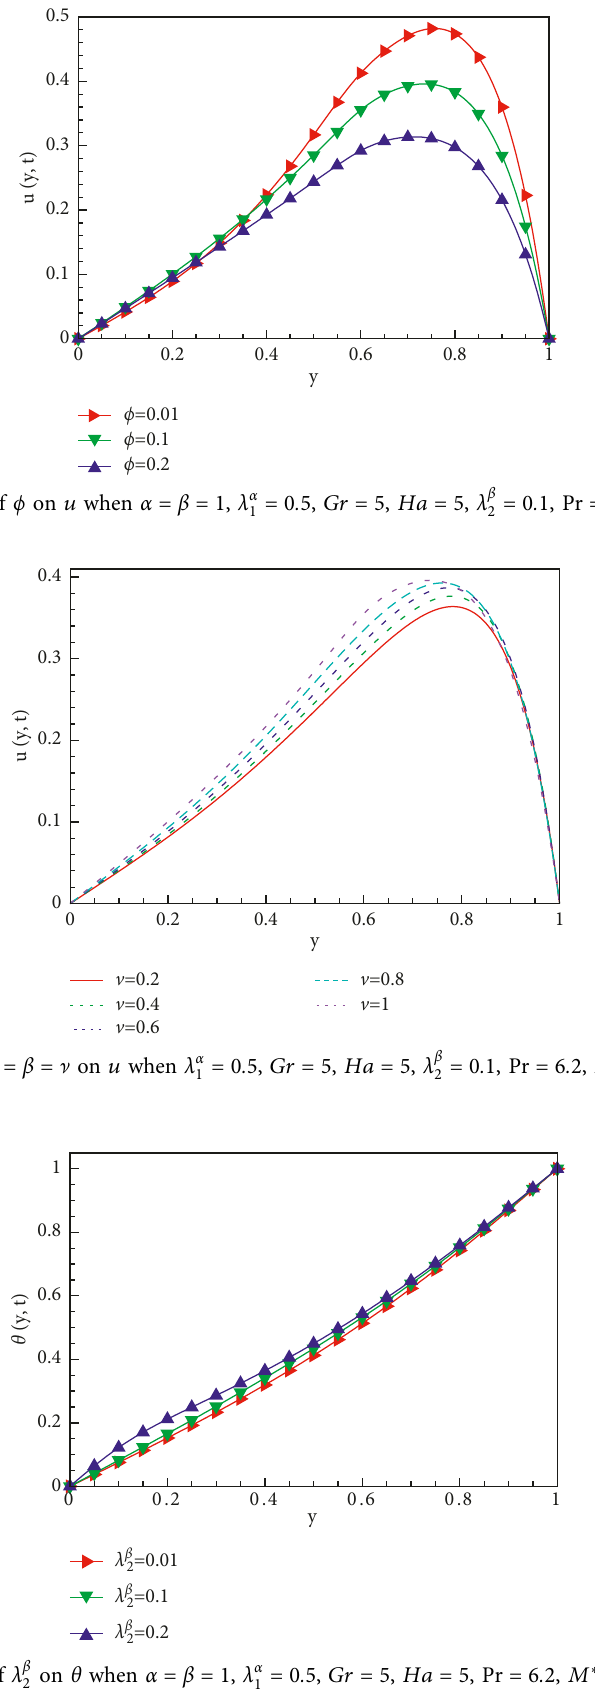
on θ when α � β � 1 , λ α 2